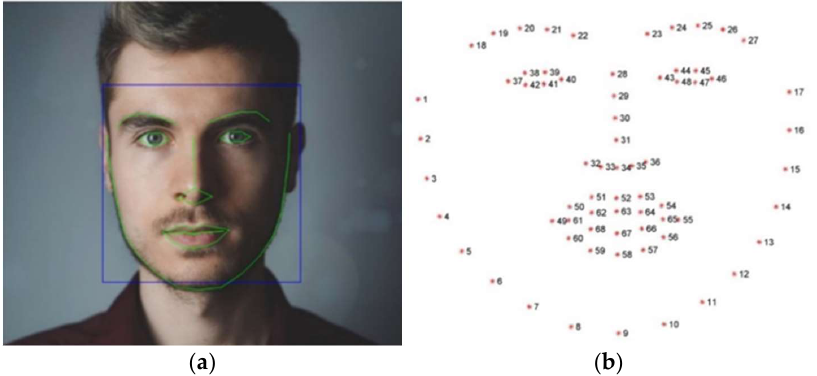
Figure 13. Illustration of 68 landmarks in a human face image: ( a ) landmark locations in green color; ( b ) landmark numbers.